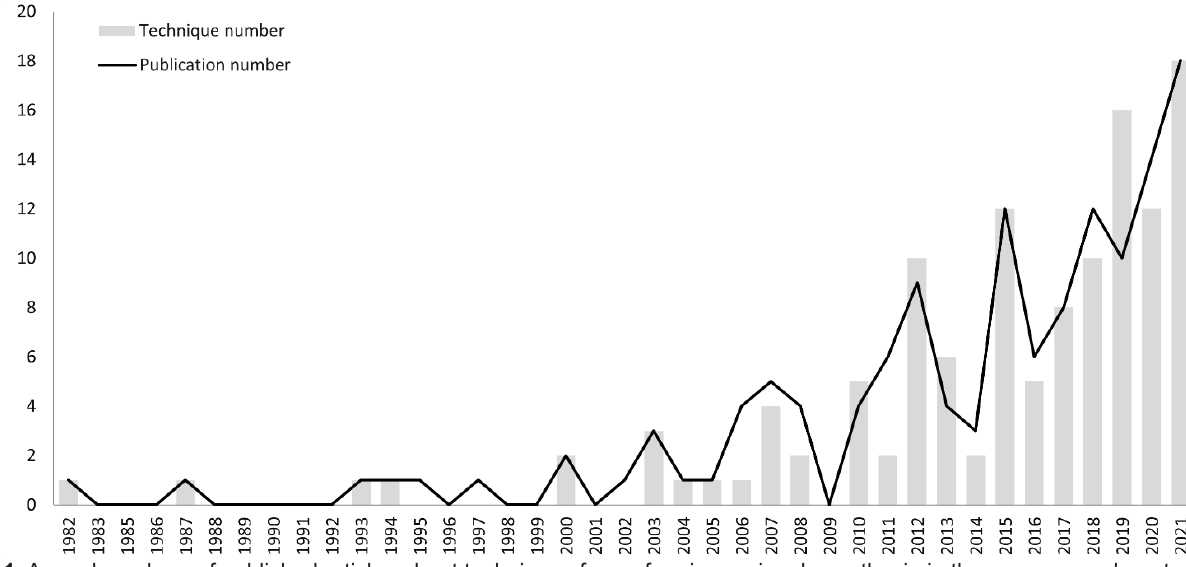
Figure 1. Annual numbers of published articles about techniques for performing regional anesthesia in the emergency